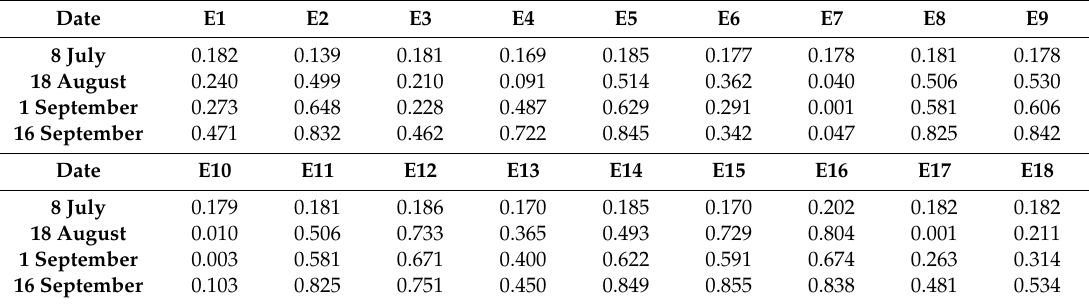
Table 2. The calculated R 2 between VI and chlorophyll contents using images acquired from di ff erent dates. Note: the data represents the time when the used images were acquired and E1–E18 are in corresponding with the VI in Table 1.